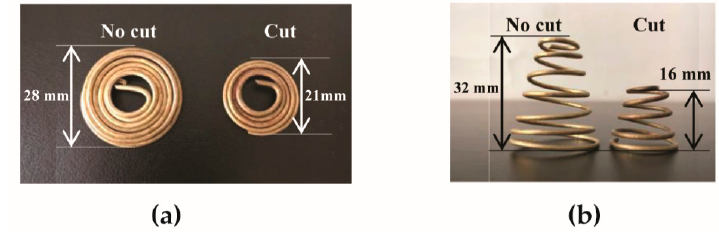
Figure 1. Two sizes of SMA spring at: ( a ) low temperature; ( b ) high temperature.